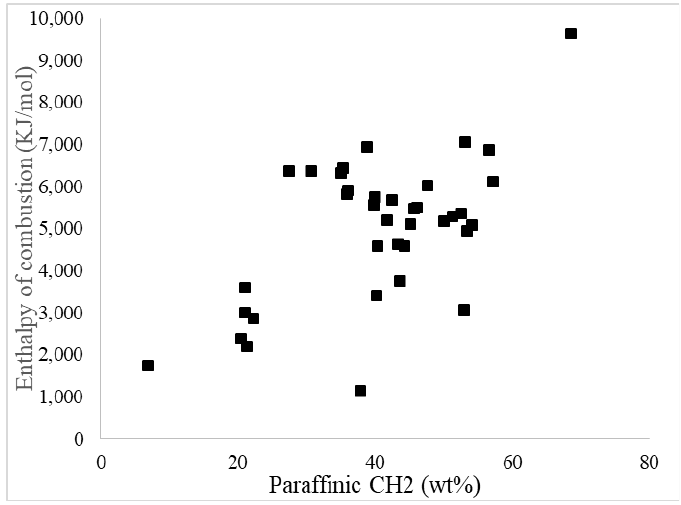
Figure 4. The effect of weight percentage of CH2 on enthalpy of combustion for blends .